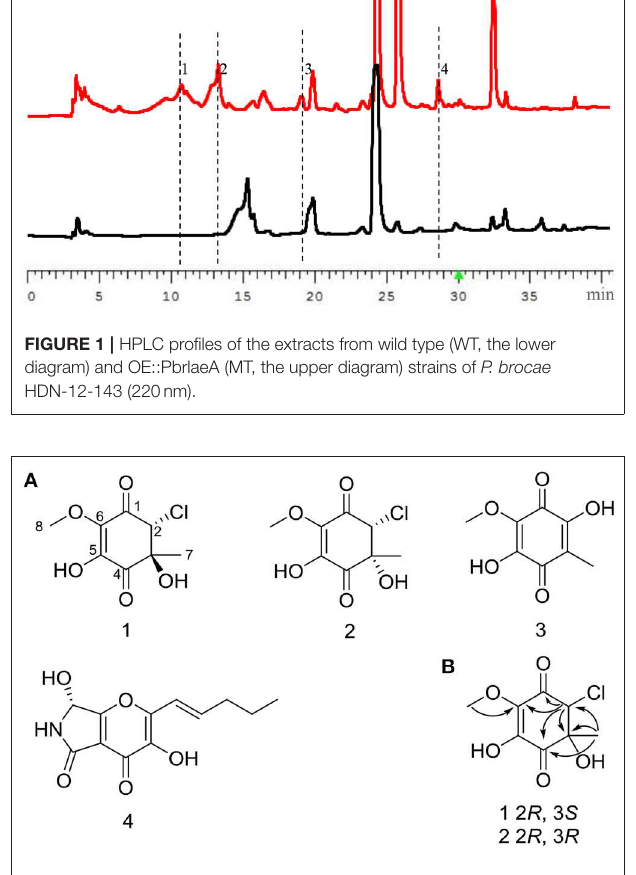
Fermentation and Chemical